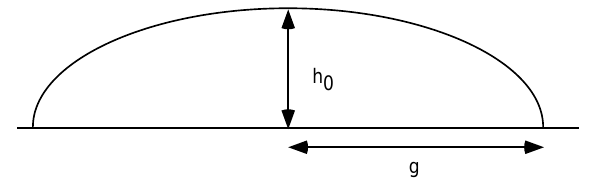
FIG. 2. Ellipsoidal protrusion on the wall.